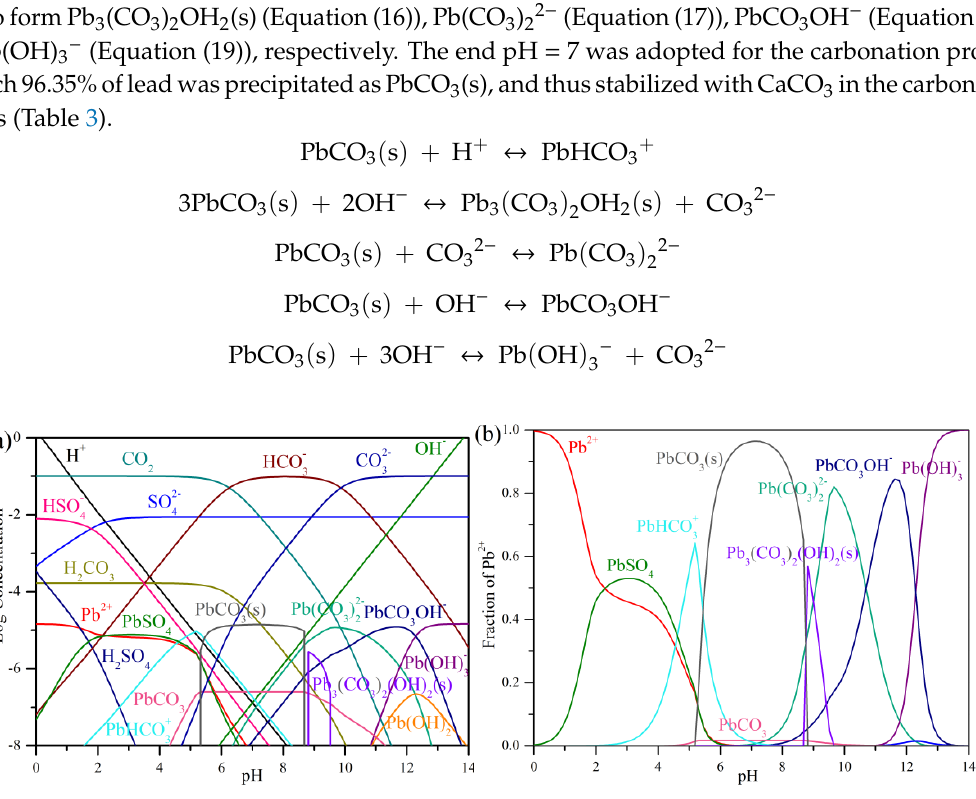
= 0.1 M with fraction of lead vs. CO 2